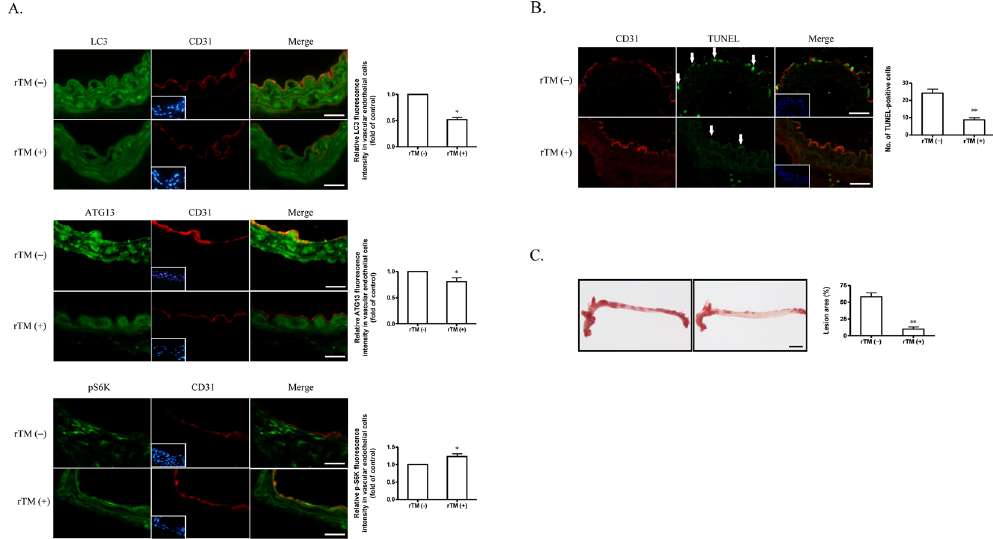
Figure 4. rTM suppresses ECs autophagy activation in apoE deficient mice. ( A ) Representative microscopic images of double immunofluorescent staining for LC3 (upper panel), ATG13 (middle panel), or p-S6K (lower panel) with CD31 (a marker for ECs) in the aortic specimens from apoE deficient mice. Nuclei were counterstained with DAPI. Bar = 50 μ m. Bar graphs showed the ratios of double staining fluorescent intensity in the mice with rTM treatment to mice without rTM treatment. Data are mean ± SEM. Three aortic sections were stained and measured. * p < 0.05 compared with the mice without rTM treatment. ( B ) Representative microscopic images of double immunofluorescent TUNEL and CD31 staining in the aortic specimens from apoE deficient mice. Nuclei were counterstained with DAPI. Bar = 50 μ m. Apoptotic cells (arrows) in aortic intimal layer were quantified by counting and averaging the number of TUNEL-positive cells in 5 aortic sections. Bar graph showed the apoptotic ECs in mice with and without rTM treatment. Data are mean ± SEM. ** p < 0.01 vs. mice without rTM treatment. ( C ) Representative images of aortas with Oil-red O staining from apoE deficient mice with (right) and without (left) rTM treatment. Bar = 500 μ m. The atherosclerotic severity was expressed as a percentage of atherosclerotic plaque area to the total aortic surface area. Bar graph showed the atherosclerotic severity in mice with and without rTM treatment. Data are mean ± SEM (n = 3). ** p < 0.01 vs. mice without rTM